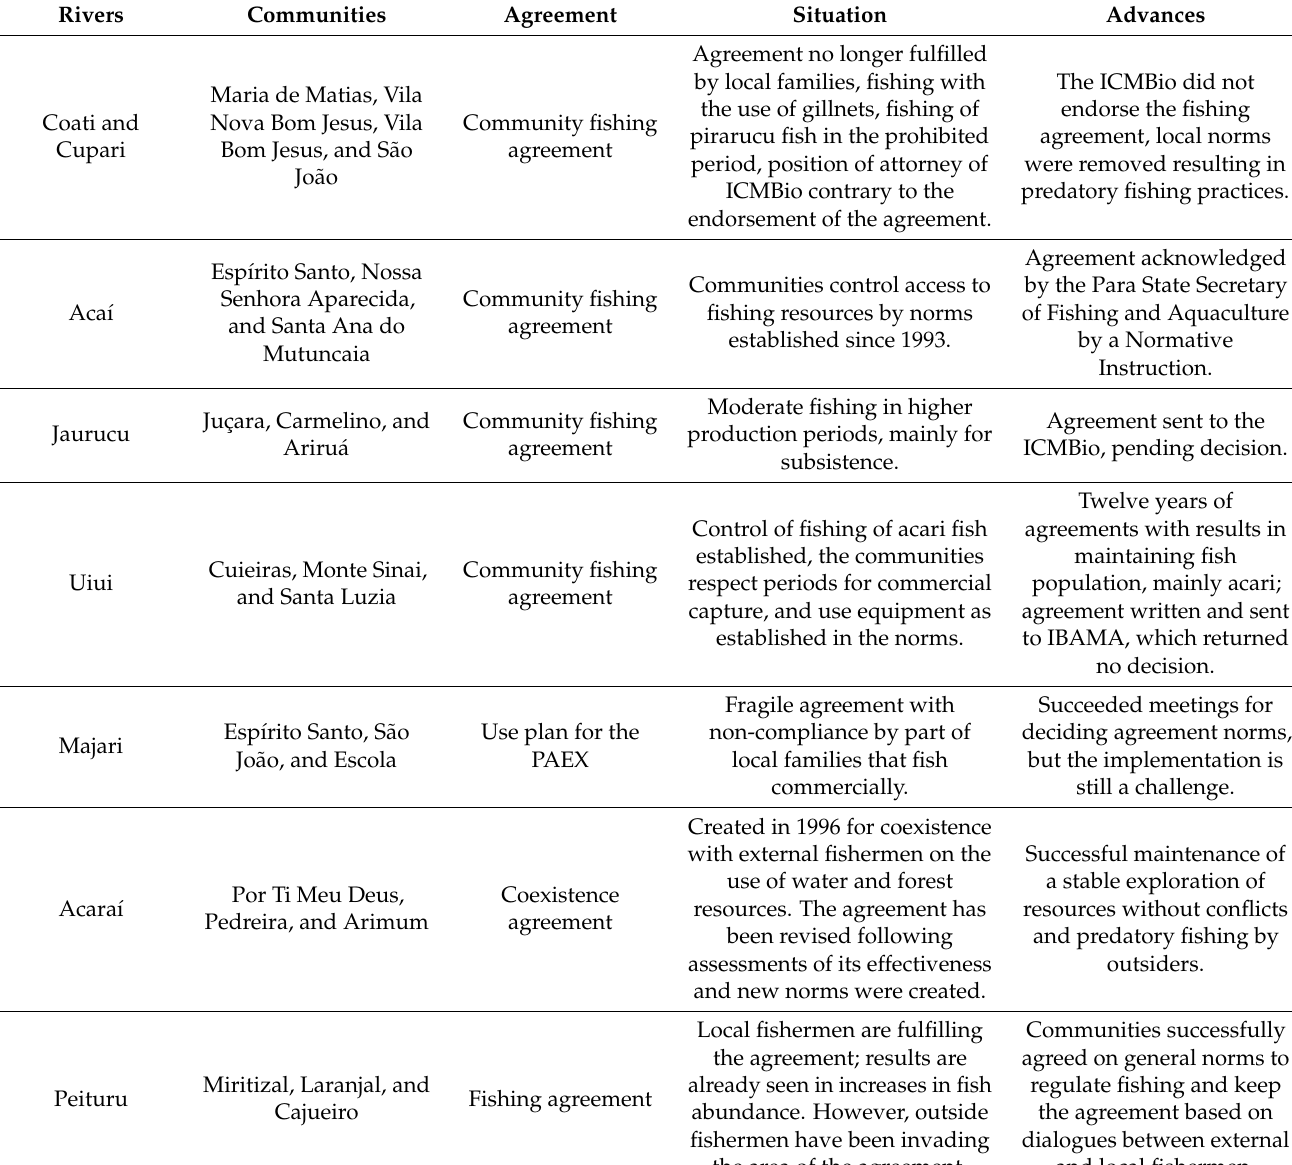
Table 2. General situation of collective management of fishing resources in Porto de